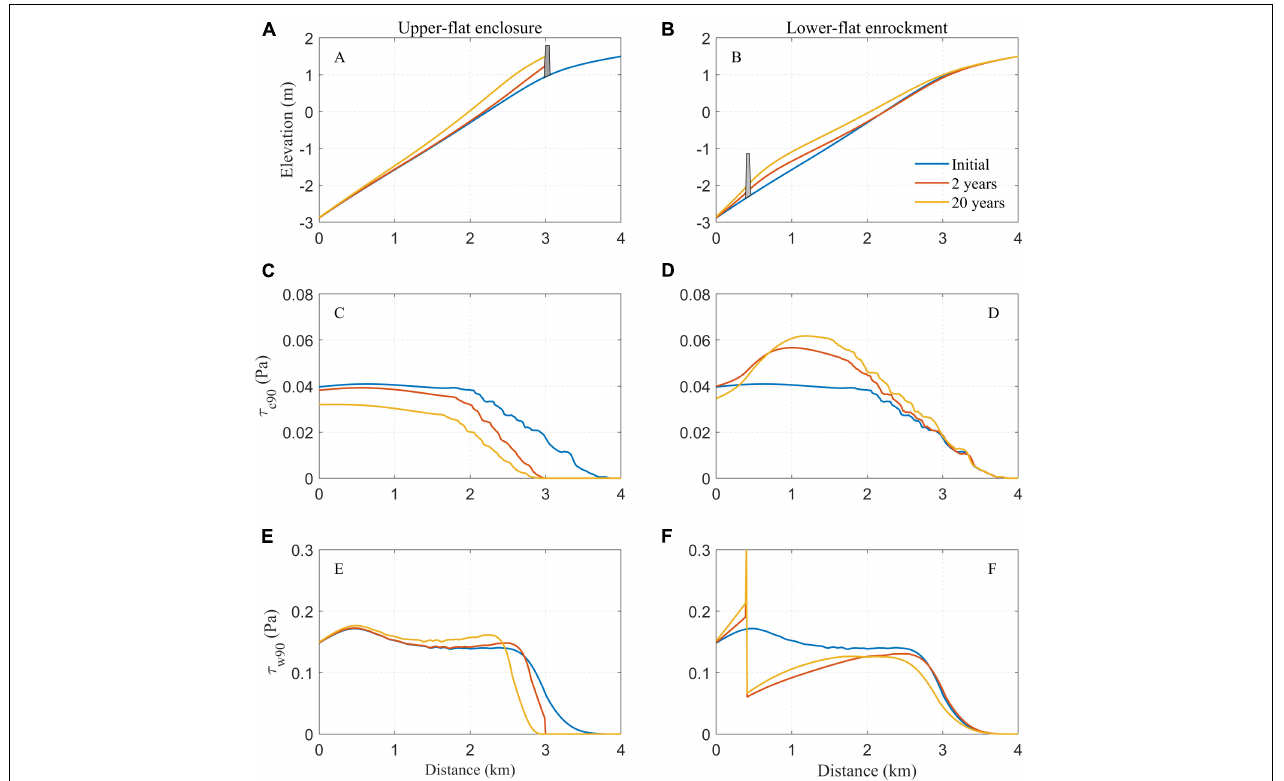
FIGURE 3 | Response of tidal flat morphodynamics to two kinds of reclamation. (A,B) The tidal flat morphological evolution induced by reclamation. (C,D) The distribution of 90th percentile tide-induced shear stress ( τ c 90 ). (E,F) The distribution of 90th percentile wave-induced shear stress ( τ w 90 ). The values in the last four panels are averaged over a spring-neap cycle (i.e., 14 tidal cycles) to eliminate the effect of varying water levels on hydrodynamics. The panels on the left side are cases of upper-flat enclosure, whereas those on the right side are for lower-flat